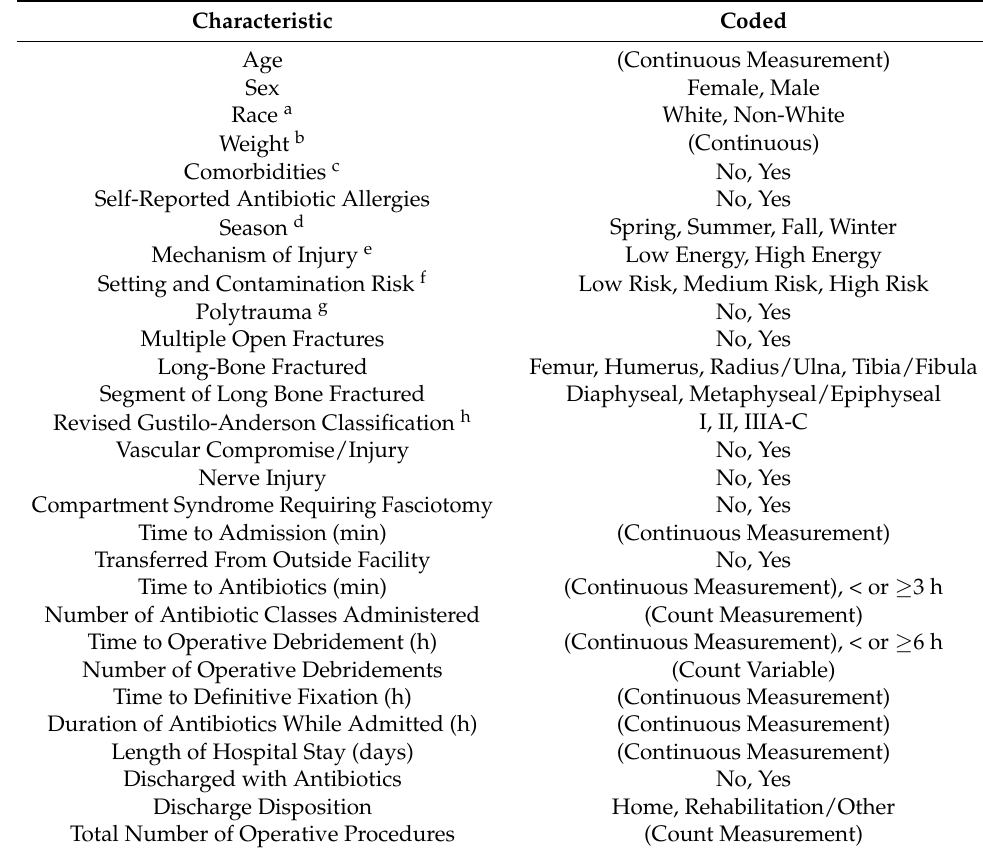
Table 1. Variables Assessed in Relation to Acquiring a Deep Infection After Pediatric Open Long-Bone